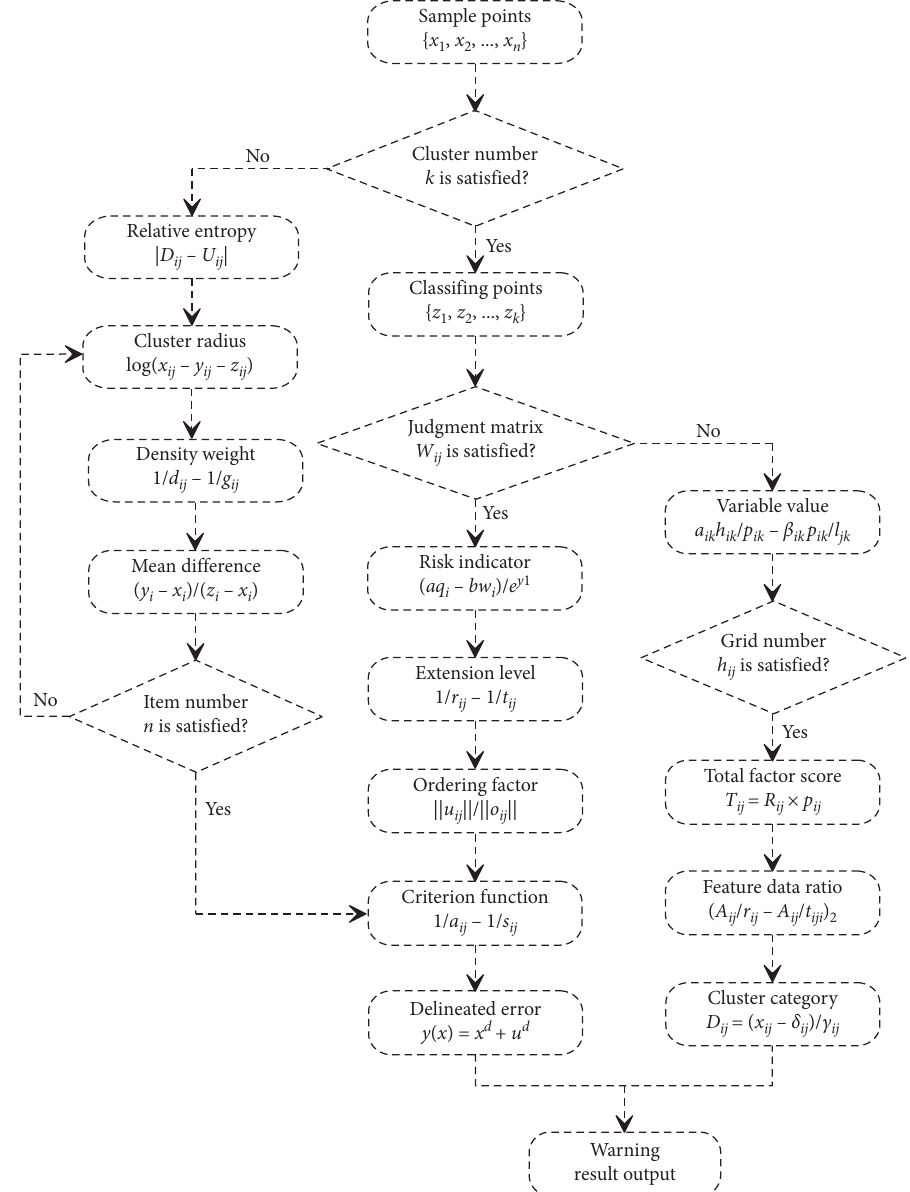
Figure 3: Flowchart of financial risk early-warning based on K-means clustering